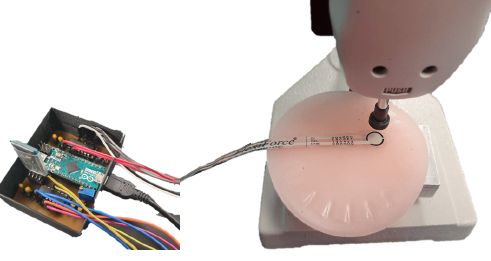
Figure 7. Characterization of SIFP via dynamometer applying various loads to a soft elastomeric material that has similar physical properties as a soft human